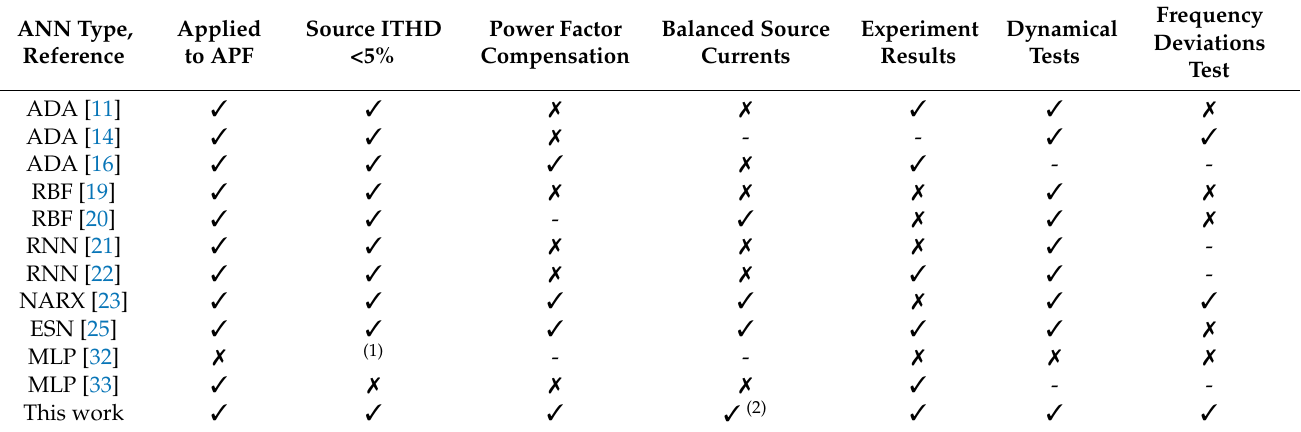
Table 3. Some features of the reference works, with control methods based on different ANN types.